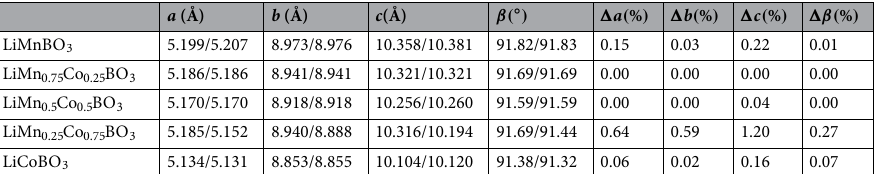
Table 1. Lattice parameters and angle of each material are presented. The numerator contains the values of our calculations, while the denominator contains experimental values published in Ref. 20 . Changes in the lattice parameters ( (cid:31) a , (cid:31) b , (cid:31) c ) and changes in the angles ( �β ) between the experimental and calculated values are